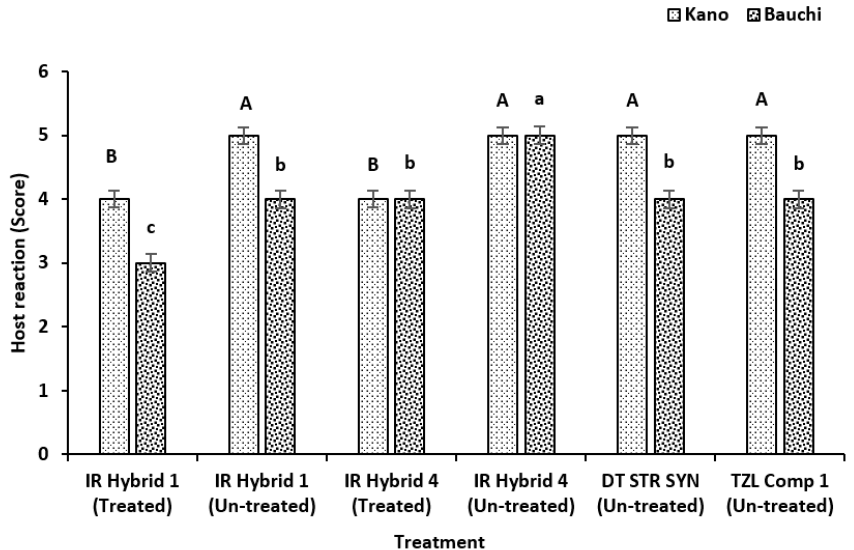
Figure 4. Host damage scores of IR maize hybrids treated with imazapyr in farmers’ fields in Kano and Bauchi